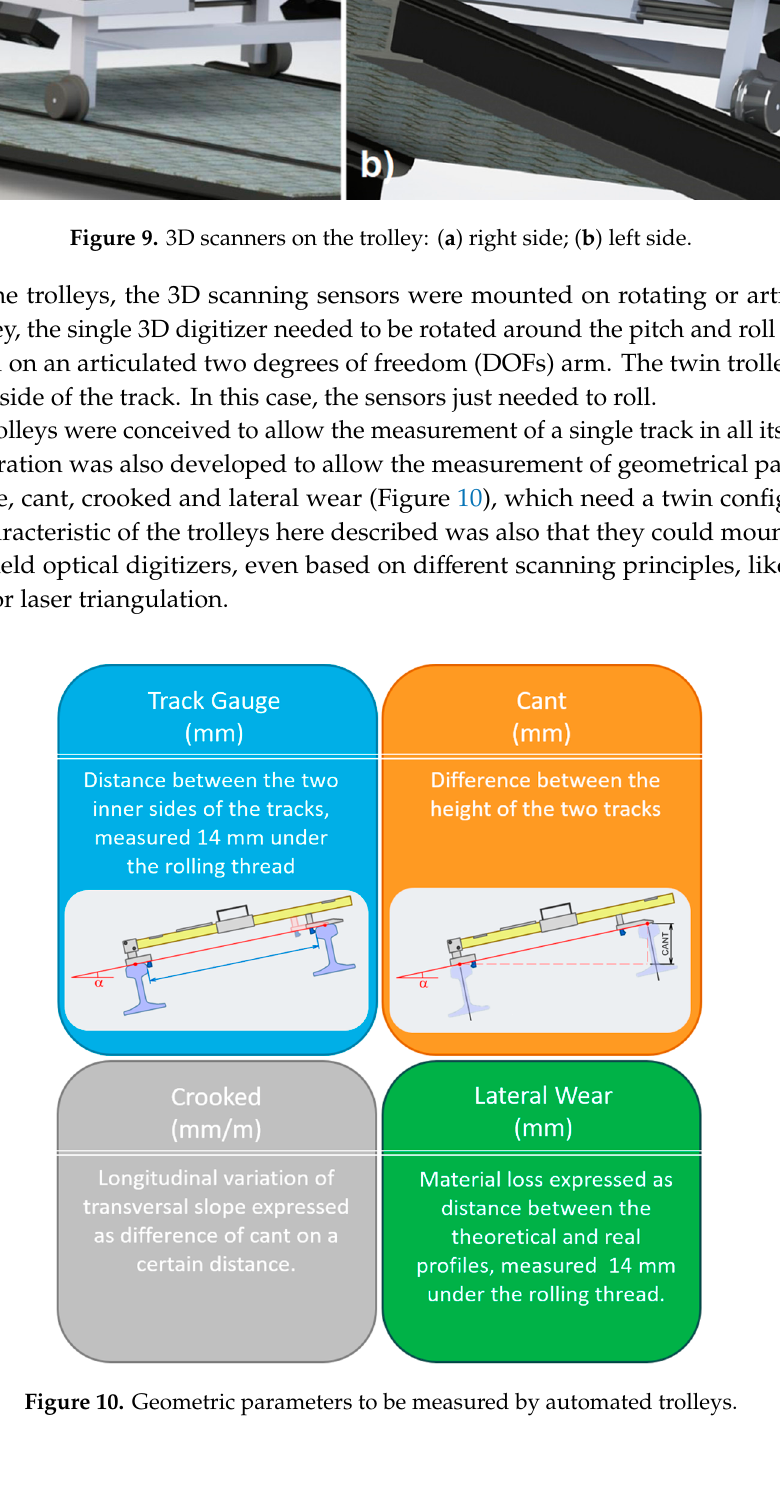
Figure 8. Twin instrumented trolley for complete 3D inspection of tracks.